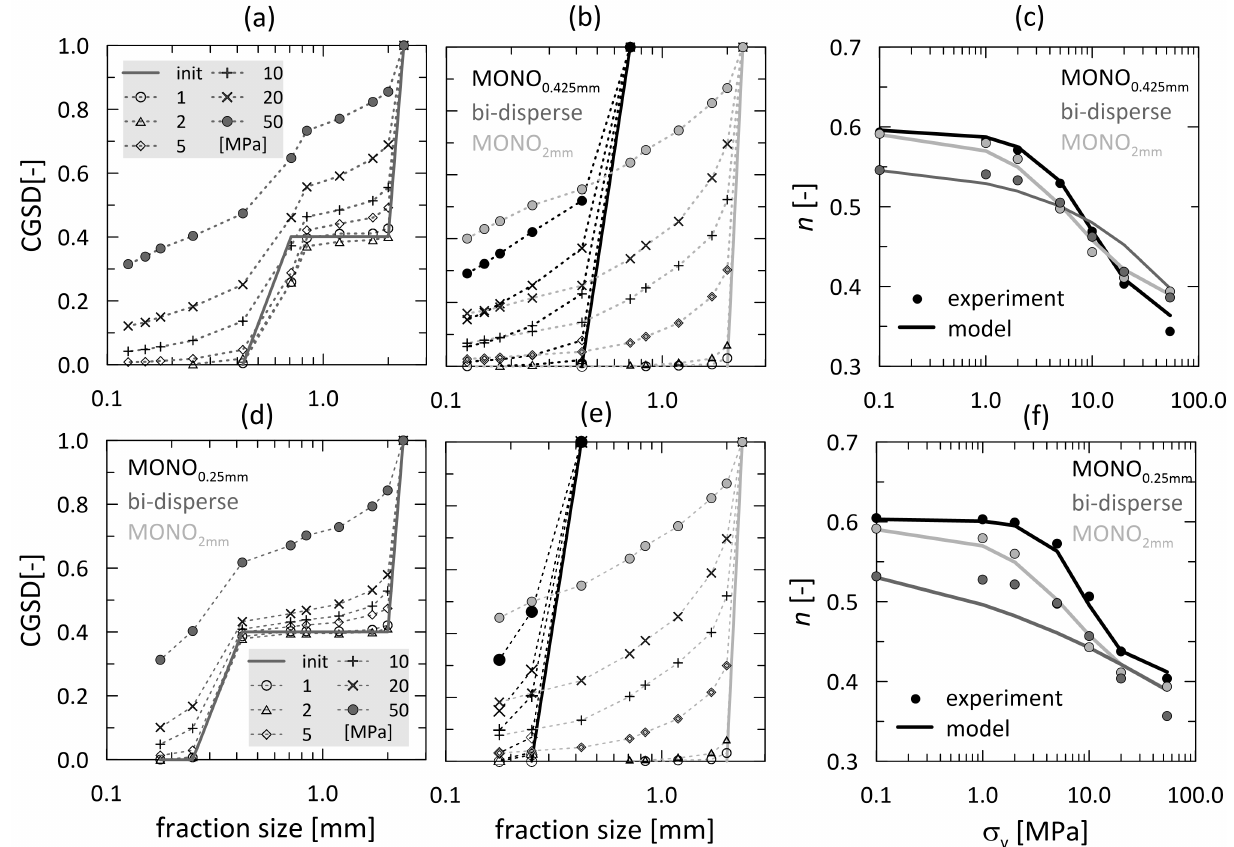
Figure 3. (a-b,d-e) CGSD evolution under 1D compression for the bi-disperse grading mixture 1(a) and 2(d), compared to the grading evolution of their relative mono-disperse ones: (b) MONO 0 . 425 mm , MONO 2 . 0 mm and (e) MONO 0 . 25 mm , MONO 2 . 0 mm . (c,f) Experimental and model prediction compressibility curves.